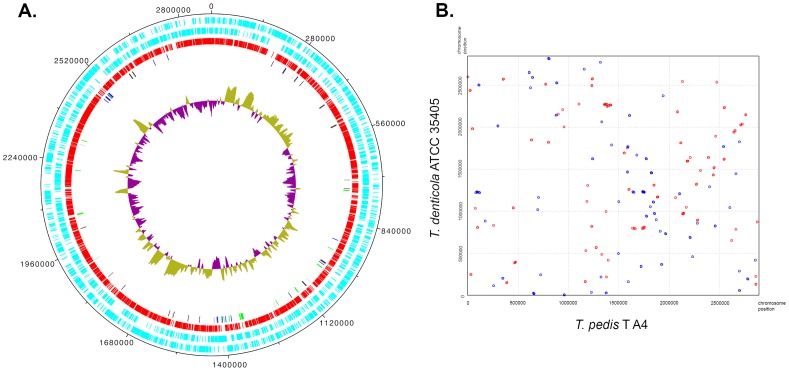
Circular representation of the T. pedis T A4 genome and complete genome alignment with T. denticola.(A.) Circular representation of the T. pedis T A4 genome. The CDSs are shown in violet where the outer circle represents predictions on the plus strand and the second circle those on the minus strand. CDSs with a best BLASTP hit in T. denticola ATCC 35405 are colored red and shown in the third circle. The fourth circle represents genes with best BLASTP hits in T. brennaborense (black), F. nucleatum (green), F. alocis (blue) and T. succinifaciens (grey). G+C skew is drawn in the inner circle. (B.) Complete genome alignment between T. pedis T A4 and T. denticola ATCC 35405. Dots represent maximum unique matches (MUMs) between the genomes. MUMs oriented in the same direction are depicted as red dots and reverse complemented MUMs are depicted as blue dots.